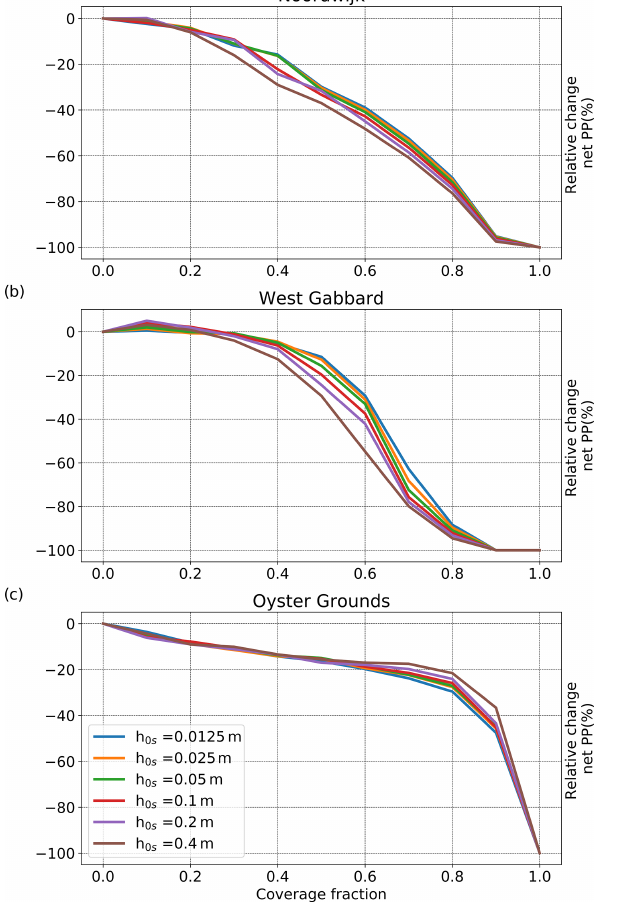
Figure 10. Relative change against the reference of net primary pro- duction with coverage for the three locations of the experiment and different values of roughness height of the platforms ( h 0s